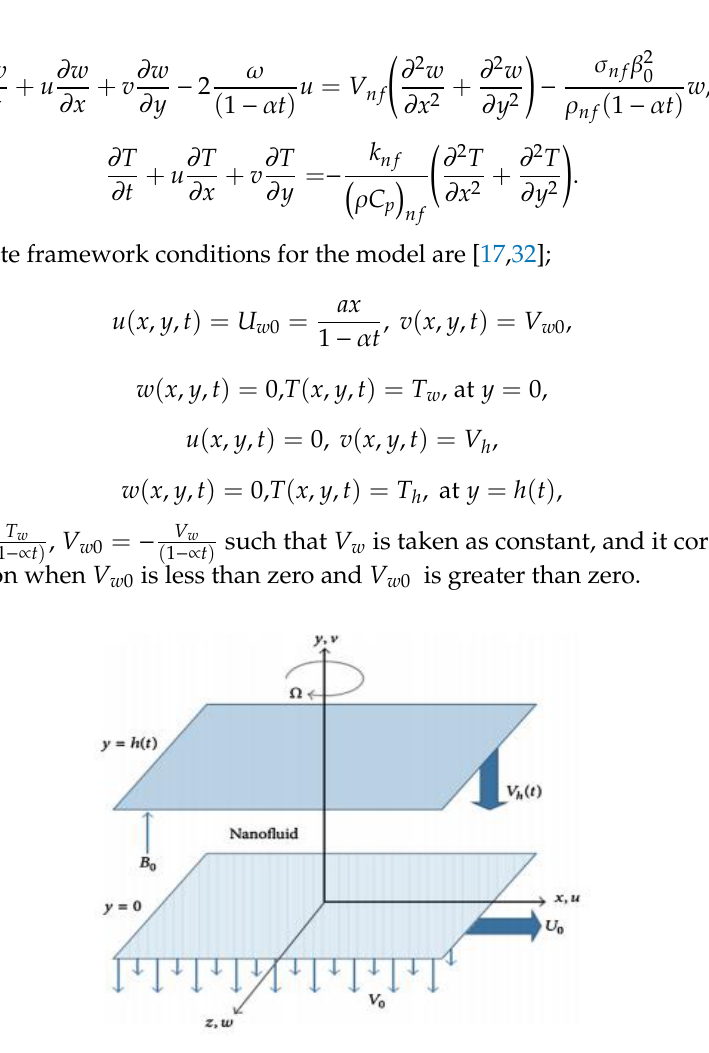
Figure 1. Schematic diagram of the flow model.